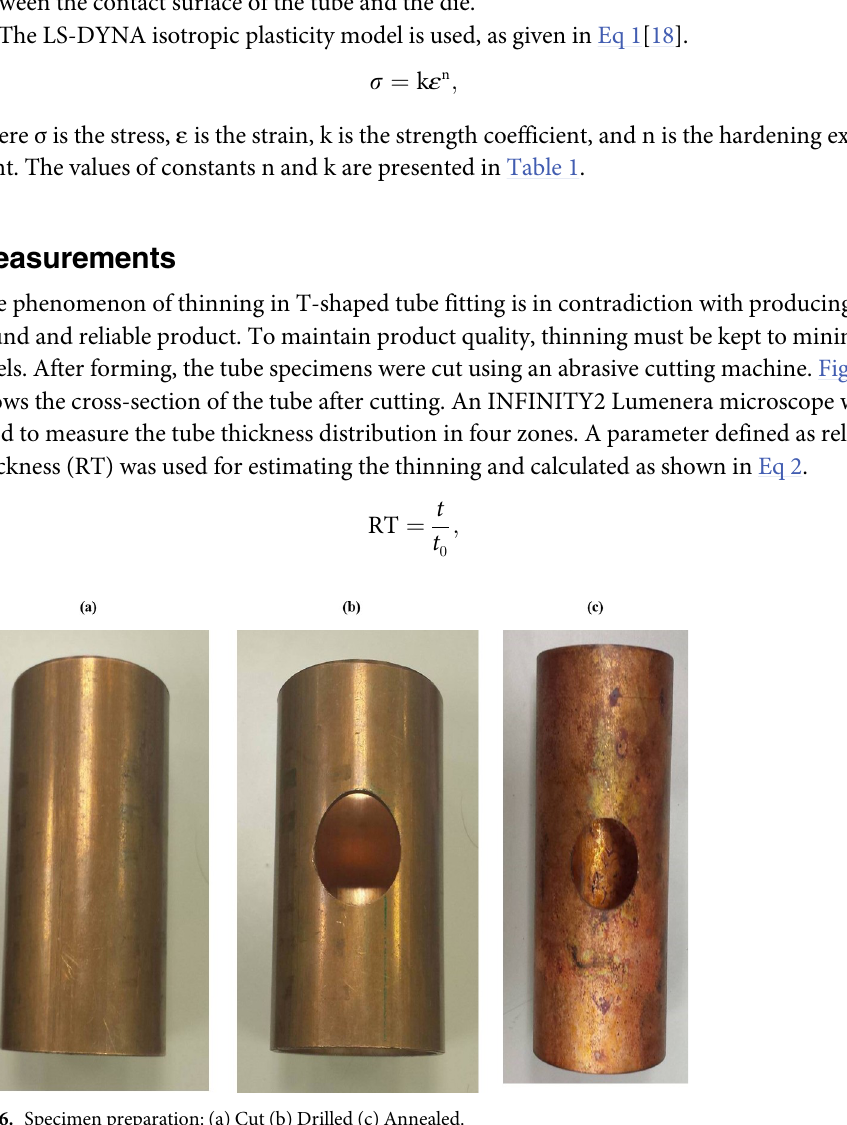
between the contact surface of the tube and the die. The LS-DYNA isotropic plasticity model is used, as given in Eq 1[18].